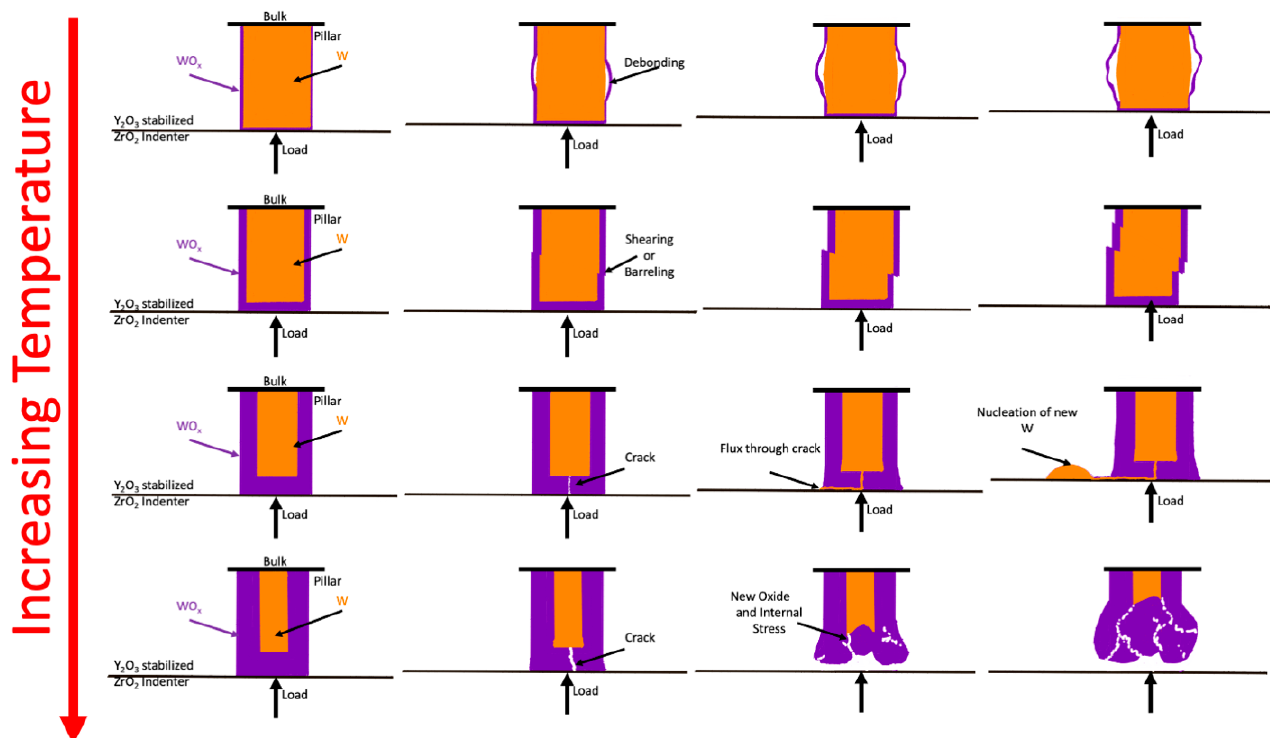
Figure 4. Schematic of the hypothesized deformation response observed in our experiments different temperature ranges. At lower temperatures, the thinner oxidation layer is hypothesized to have limited effect on the deformation modes. At higher temperatures, the constraint of a thicker oxidation layer is hypothesized to drive localized plasticity via a creep mechanism. Rapid oxidation occurs at 1250 °C.